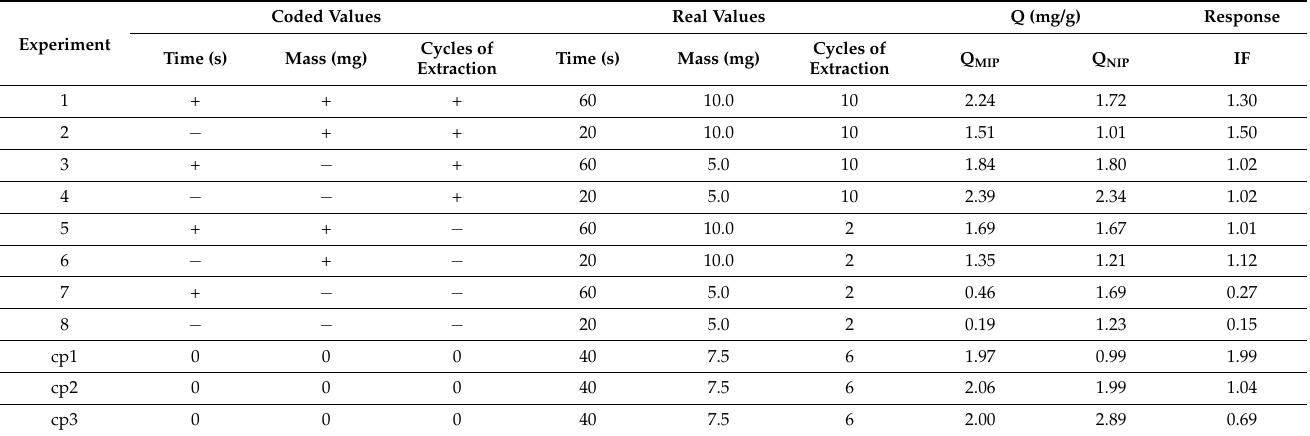
Table 2. The 2 3 factorial design parameters and analytical response for the MISPE-DPX extraction